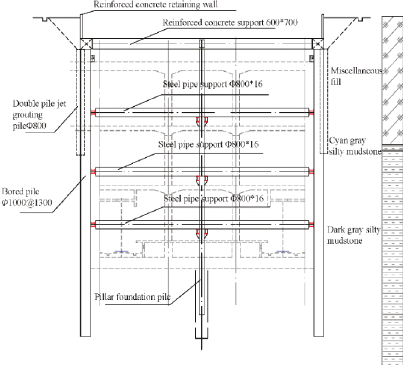
Figure 3: Cross section of the foundation pit.